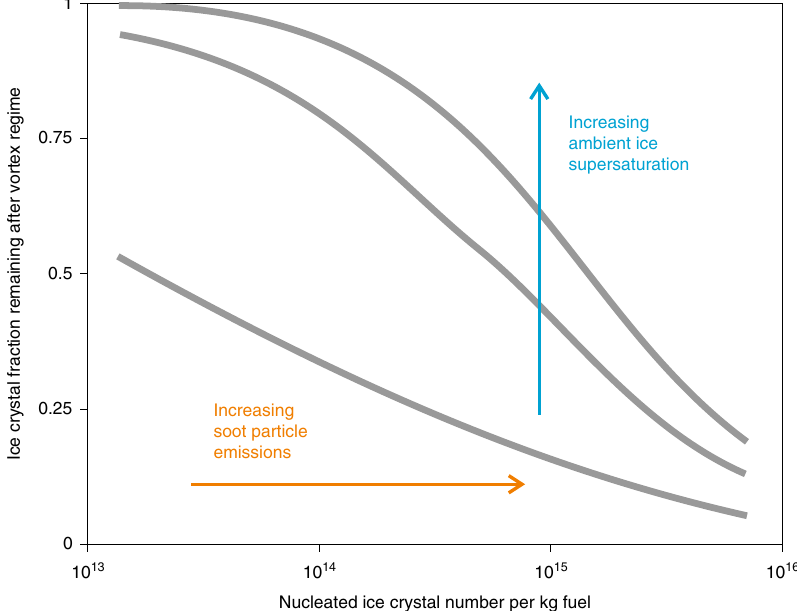
Fig. 4 Sublimation-induced ice crystal losses in aircraft wakes. Dependence of the fraction of ice crystals escaping complete sublimation during the vortex regime versus nucleated ice crystal number emission index taken from LES simulations for a large aircraft at cruise and low (0.1), medium (0.2) and high (0.3) ambient ice supersaturation (Table A2 Block 4 in ref. 43 ). The magnitude of sublimation losses depends on aircraft engine thrust settings affecting soot particle numbers as well as on aircraft weight affecting the vertical depth of the wake; ambient conditions including ice supersaturation, air temperature and its vertical gradient and turbulence levels; and level of plume ice supersaturation and number, mean size and spread of the contrail ice crystal size distribution in the late jet regime. Substantial losses have been attributed to the Kelvin effect 31 , marking an increase in supersaturation over the surfaces of small particles relative to ambient values. Although this increase is very small (0.001 – 0.1) for µ m-sized ice crystals, it becomes important in aircraft wake vortices for high ice crystal number concentrations causing rapid sublimation rates